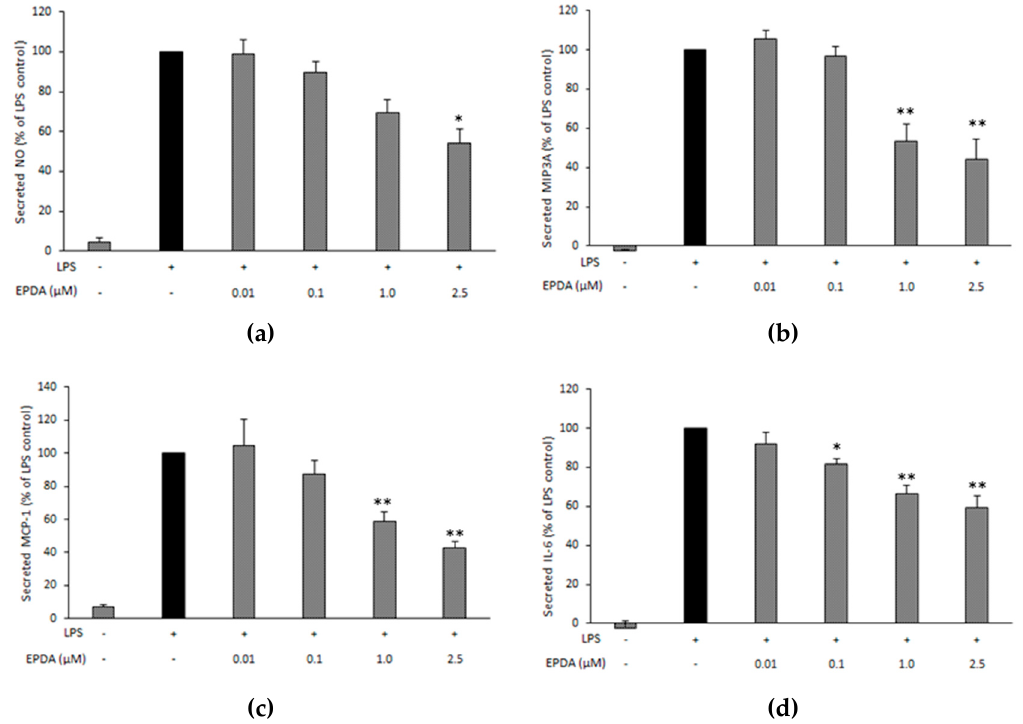
Figure 2. Effect of N -eicosapentaenoyl dopamine (EPDA) on the secreted nitric oxide (NO) ( a ), macrophage-inflammatory protein-3 α (MIP3A) ( b ), chemokine monocyte chemoattractant protein-1 (MCP-1) ( c ) and interleukin-6 (IL6) ( d ) by RAW264.7 macrophages exposed to lipopolysaccharide (LPS). Cells were seeded in 48-well plates at 250000 cells mL − 1 . After overnight incubation, cells were treated with (or without) LPS (0.5 µ g mL − 1 ) and with (or without) EPDA (concentration range of 0.01–2.5 µ M) for 24 h (for proteins) or for 48h (for NO). Cell supernatants were evaluated for nitrite concentration and secreted proteins using an ELISA reader. Results are expressed as percentages of LPS control (black bar, set at 100%), and represent the mean of three independent experiments (each done in duplicate) ± S.D. Average absolute value for nitrite production with LPS stimulation (LPS control) after 48 h was 24 ± 5 µ M. Average absolute values for MIP3A, MCP-1, and IL-6 with LPS stimulation (LPS control) after 24 h were 384 ± 67 pg mL − 1 , 38 ± 3 ng mL − 1 , 74 ± 4 ng mL − 1 , respectively. Asterisks indicate significantly di ff erent mean values from those of control (* p < 0.05, and ** p < 0.01).